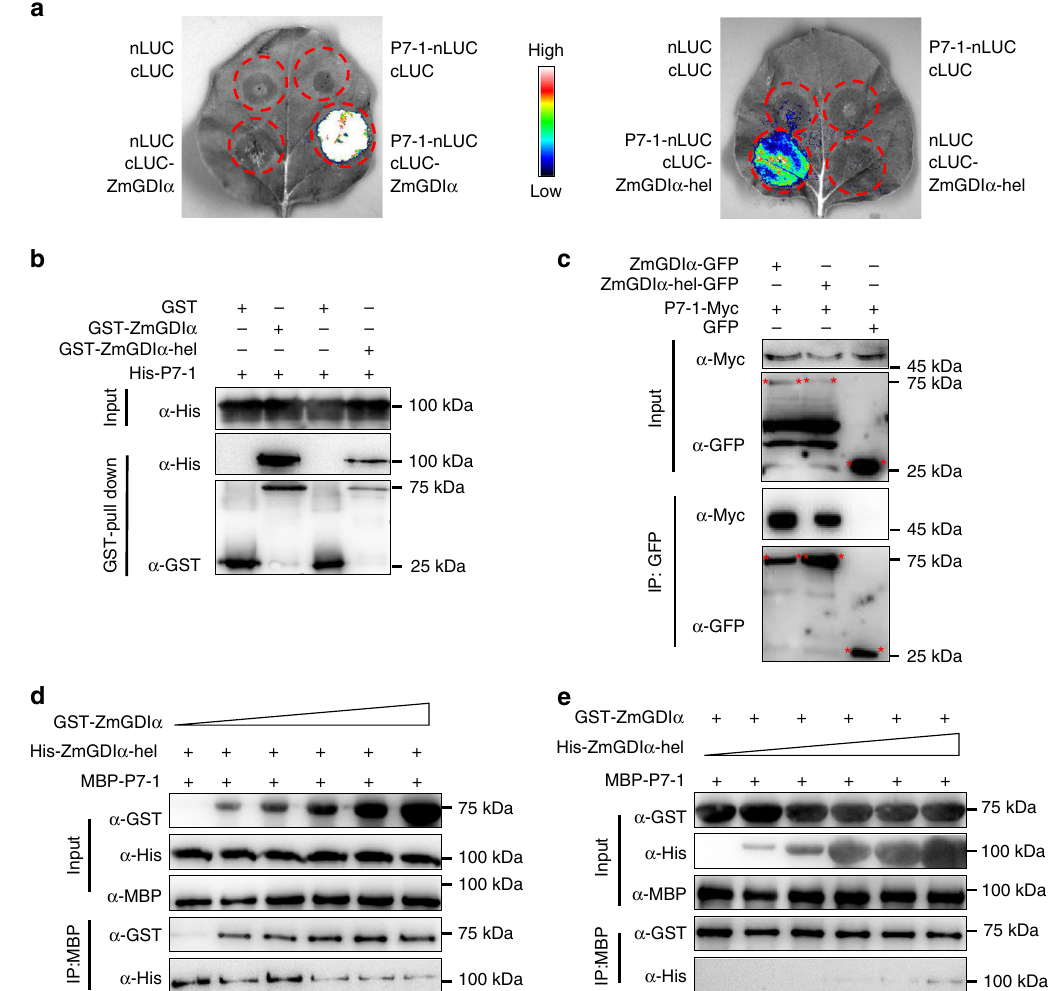
Fig. 4 The viral P7-1 protein binds more tightly to ZmGDI α than to ZmGDI α -hel. a Split-luciferase complementation assay to show the interaction of viral P7-1 with ZmGDI α or ZmGDI α -hel. Fluorescence signals appeared where P7-1-nLUC was co-expressed with cLUC-ZmGDI α (left) or cLUC-ZmGDI α -hel (right) in N. benthamiana leaves. The high-low reference bar shows fl uorescence signals, ranging from high (top, white with red) to low (bottom, blue). b GST pull-down assay to show the interactions of both ZmGDI α and ZmGDI α -hel with viral P7-1 in vitro. Pull-down of the His-P7-1 fusion protein is detected by immunoblotting with an anti-His antibody. c Co-immunoprecipitation assay to show the interaction of viral P7-1 with ZmGDI α or mGDI α -hel in vivo. P7- 1-Myc and ZmGDI α -EGFP (or ZmGDI α -hel-EGFP) were detected by immunoblotting with anti-Myc and anti-GFP antibody, respectively. d Competitive protein-binding assay with a fi xed amount of His-ZmGDI α -hel (200 μ g). The interacting proteins were pulled down with anti-MBP amylose resin and detected by immunoblotting with either GST (for GST-ZmGDI α ) or His (for His-ZmGDI α -hel) antibody. e Competitive protein-binding assay with a fi xed amount of GST-ZmGDI α (200 μ g). In the inverse experiment to that in d , the interacting proteins were pulled down with anti-MBP amylose resin and detected by immunoblotting with either GST (for GST-ZmGDI α ) or His (for His-ZmGDI α -hel) antibody. Each of above fi ve experiments was repeated three or more times independently, with the similar results. Source data are provided as a Source Data fi